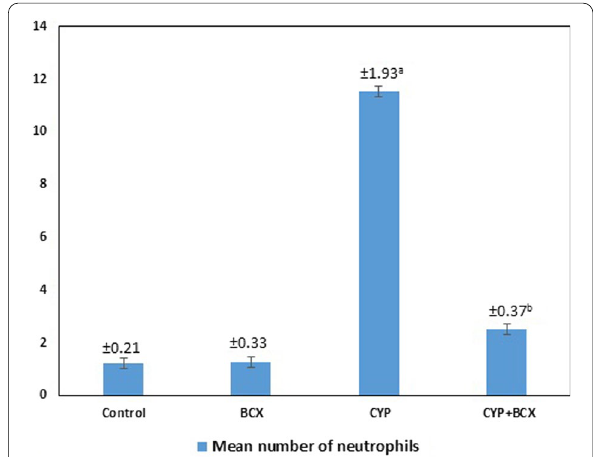
Fig. 4 Mean number of neutrophils per 10 high-power fields in the studied groups tested by using Student’s t test. a P < 0.05 is significant in group III versus group I and b P < 0.05 is significant in group IV versus group